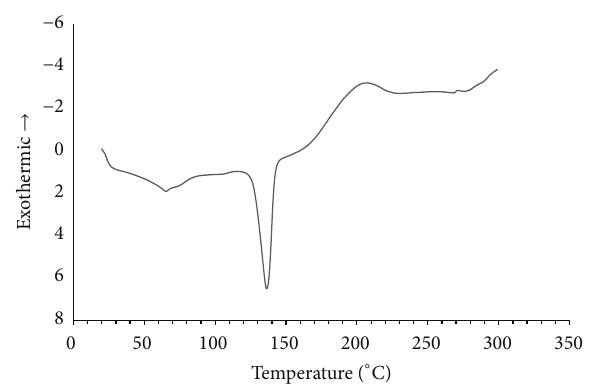
Figure 4: DSC thermograph of UHMWPE fibre.